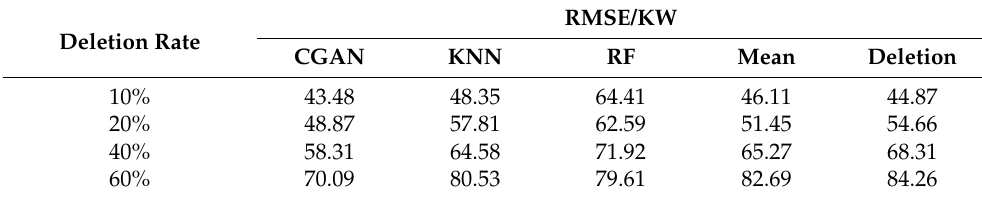
Table 5. Influence of different processing methods on root mean square error of prediction.